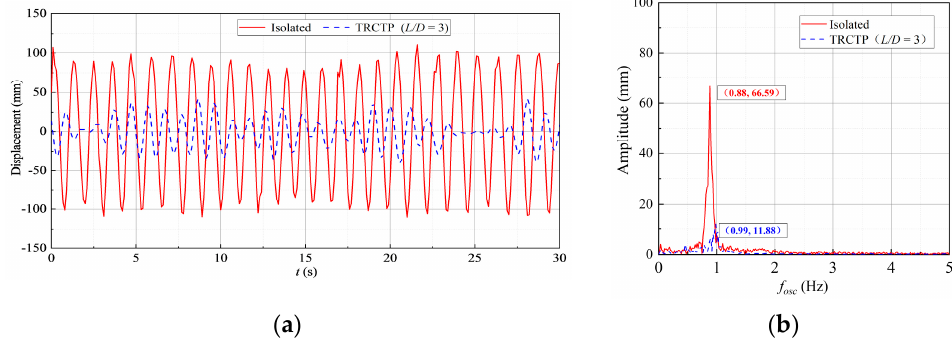
Figure 13. Typical displacement and spectra at U r = 8.5 ( L / D = 3). ( a ) Comparison of displacement time history; ( b ) Comparison of spectra.